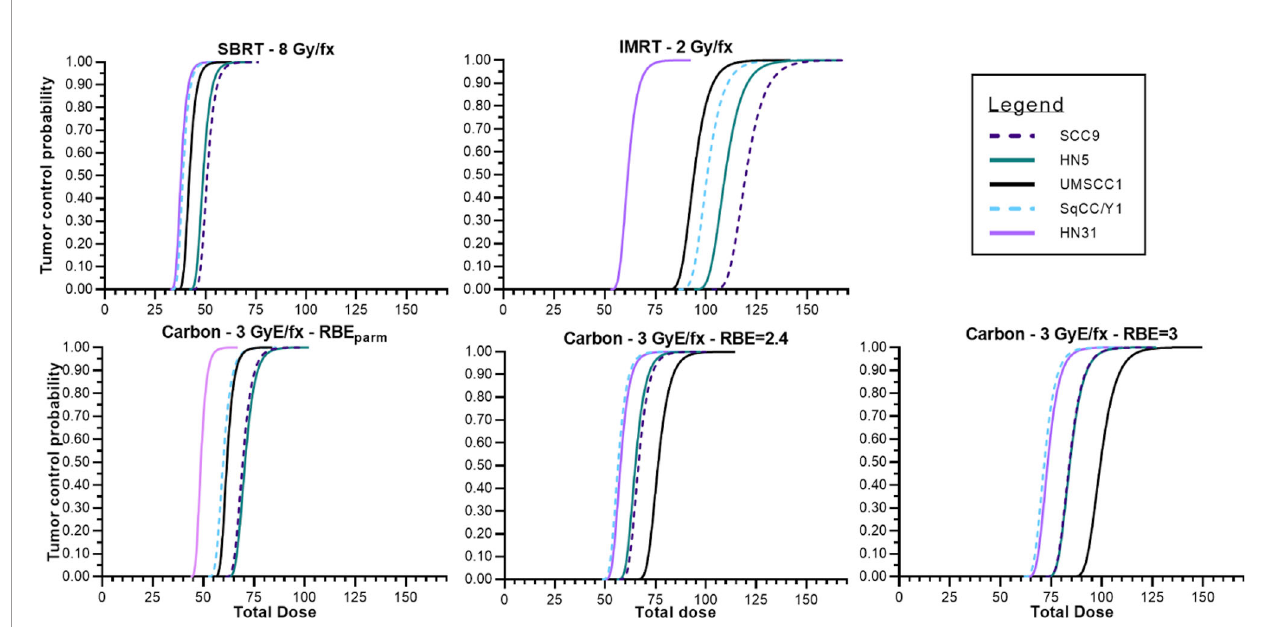
FIGURE 5 | Tumorcontrol probabilities for varioustreatment modalities across the panelofHNSCC cell lines assuming nohypoxia, tumorsthat are a volume of 1 cm and containing 10 8 tumor cells. PhotonIMRT, SAbR, 12 C using a fi xed RBE to determine GyE, 12 C using the RBE associated with the cellline used for tumor